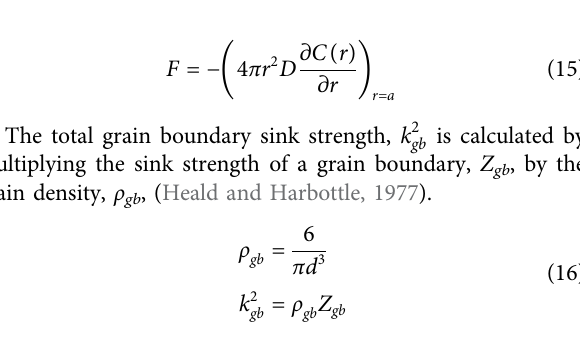
Frontiers in Materials |